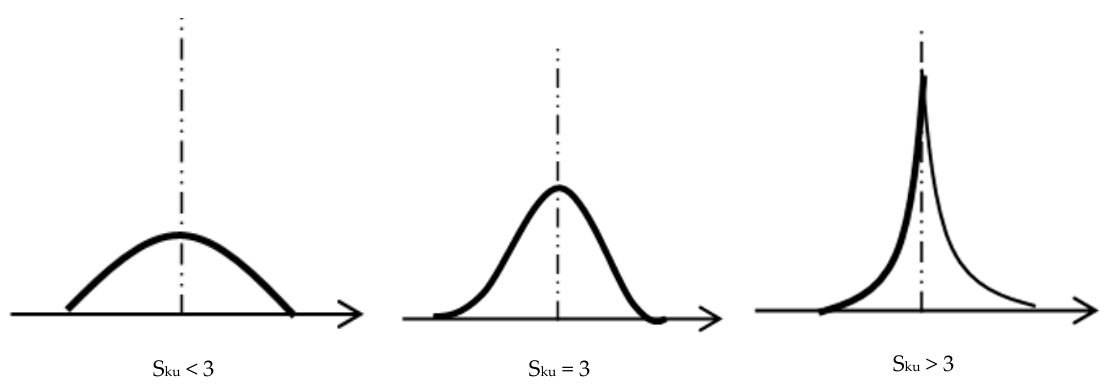
Figure 4. Probability density functions for random distributions with different Kurtosis.